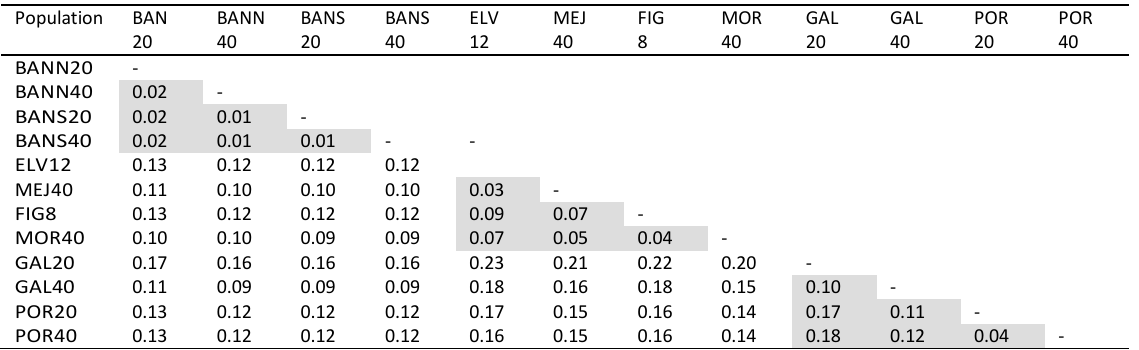
Table S1. Pairwise F ST estimates using only putatively neutral SNPs. All comparisons were highly significant. Intra-region comparisons are highlighted.